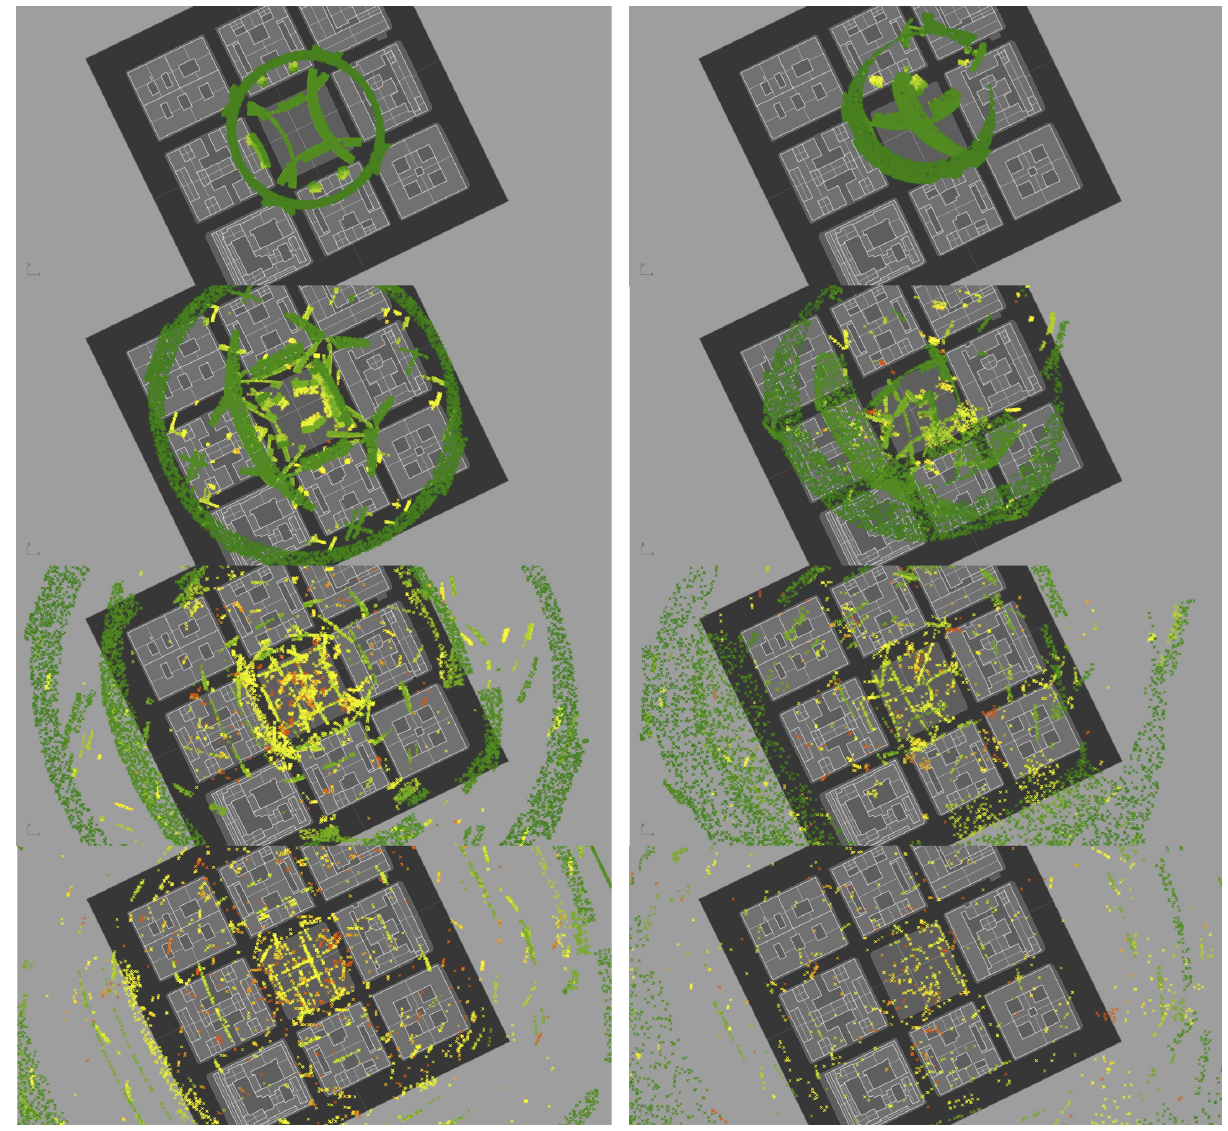
Figure 8: Ray-tracer images of Piazza Testaccio. ( A ) the point source is placed in the center of the piazza. ( B ) the source is placed in the North corner. Frames taken at 20-40-70 and 100 milliseconds. Many particles, trapped in by reflections, can be found uniformly scattered, following both initial configurations. This feature rapidly destroys information about source